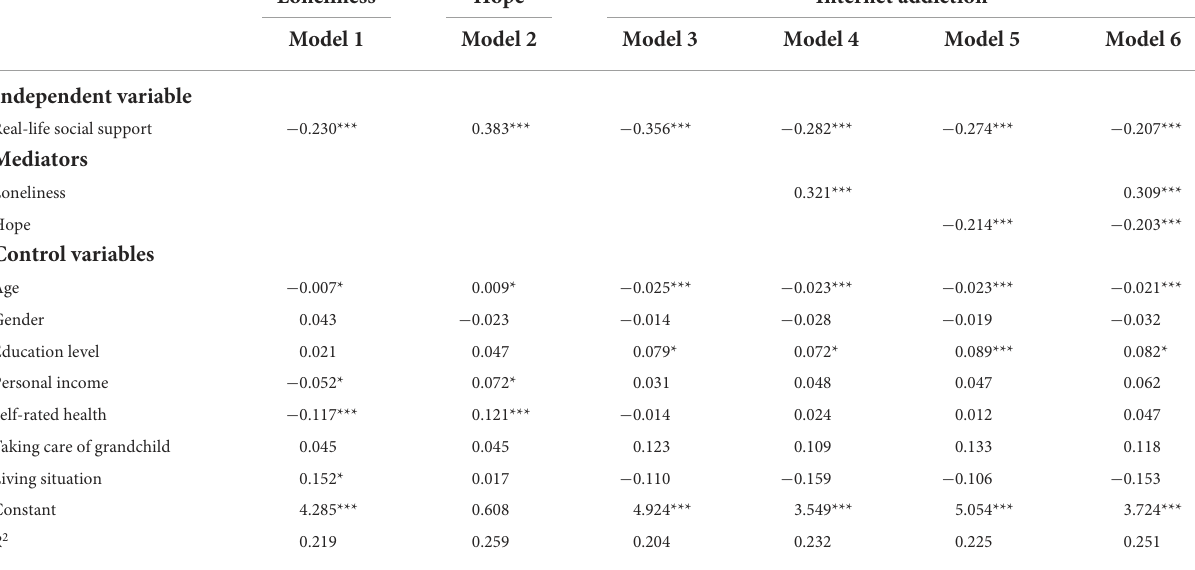
TABLE 3 Regression coefficients in the mediation